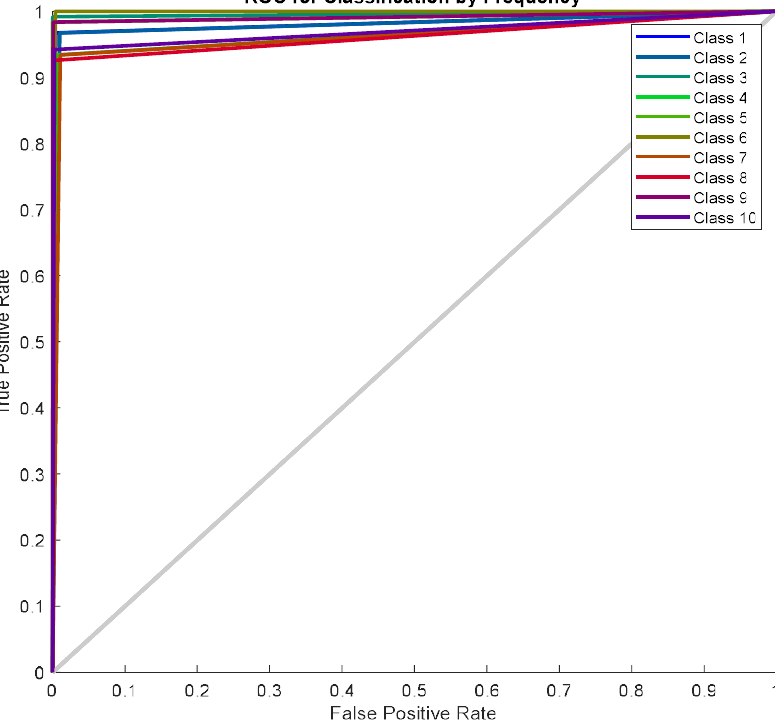
Figure 34. ROC for noisy LFM by 2 D-CNN.